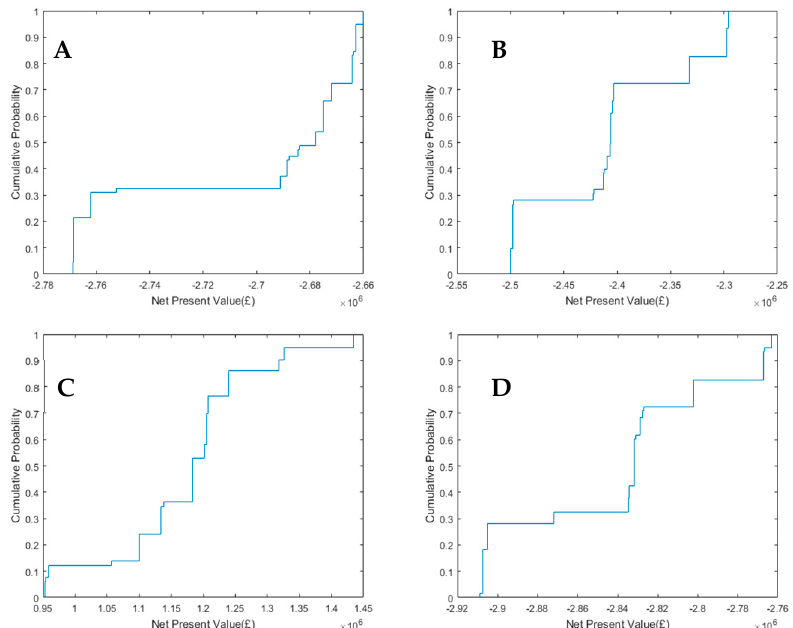
Figure 6. Empirical Cumulative Distribution Function of the Net Present Values for paths D (subfigure ( A )), H (subfigure ( B )), L (subfigure ( C )), and Q (subfigure ( D )).